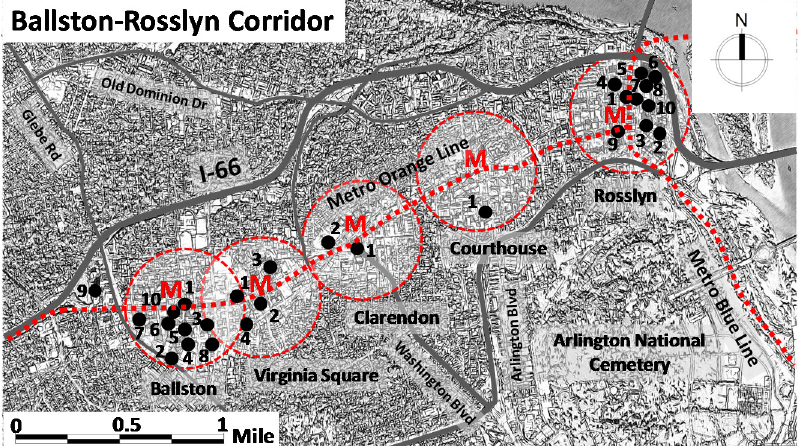
Figure 8. The spatial distribution of the tallest buildings in the Ballston-Rosslyn Corridor, Arlington, VA. They are clustered within a quarter-mile radius of their respective metro stations in the five neighborhoods: Ballston, Virginia Square, Clarendon, Courthouse, and Rosslyn.